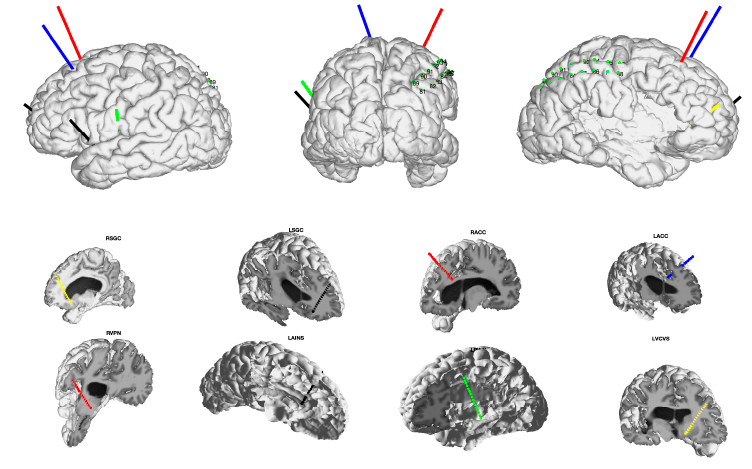
Figure 1. Stereoelectroencephalography (sEEG) targeting for deep brain stimulation (DBS) for chronic pain during the inpatient trial period. Top row depicts left lateral, posterior, and right lateral views in an example patient with post-stroke pain. Eight images across rows 2 and 3 depict individual electrode trajectories targeting labeled regions of interest. R/LSGC: right /left subgenual cingulate cortex, R/LACC: right/left anterior cingulate cortex, RVPN: right ventral posterior thalamic nucleus, LAINS: left anterior insula, LPINS: left posterior insula, LVCVS: left ventral capsule and ventral striatum.